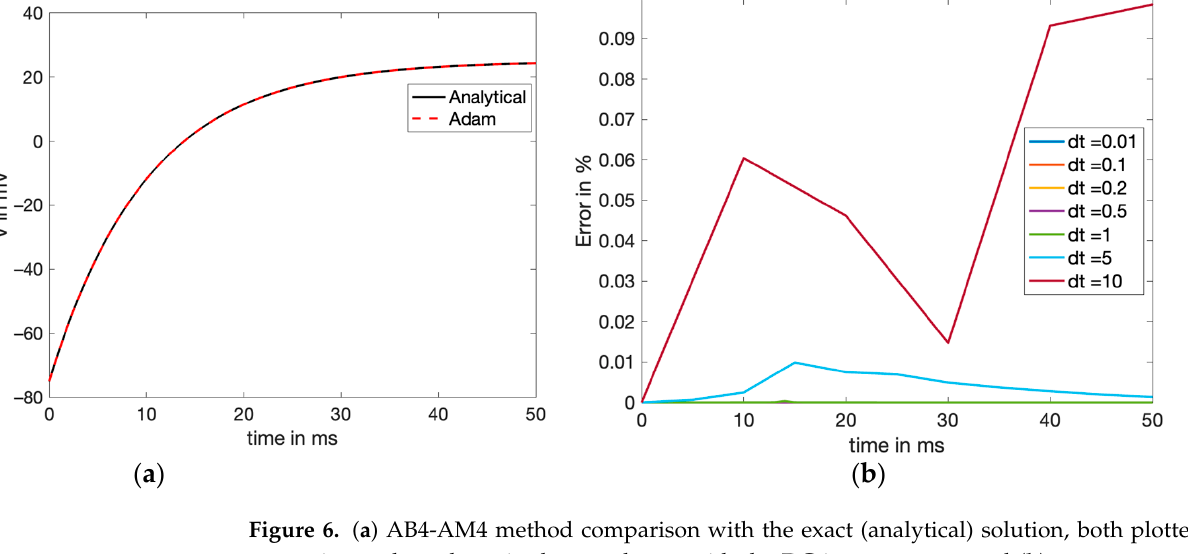
Figure 5. Effect of the constant current on the membrane ( top ) and Heun’s method compared with analytical solution ( bottom ) for step size ( dt ) = 0.2 ms.